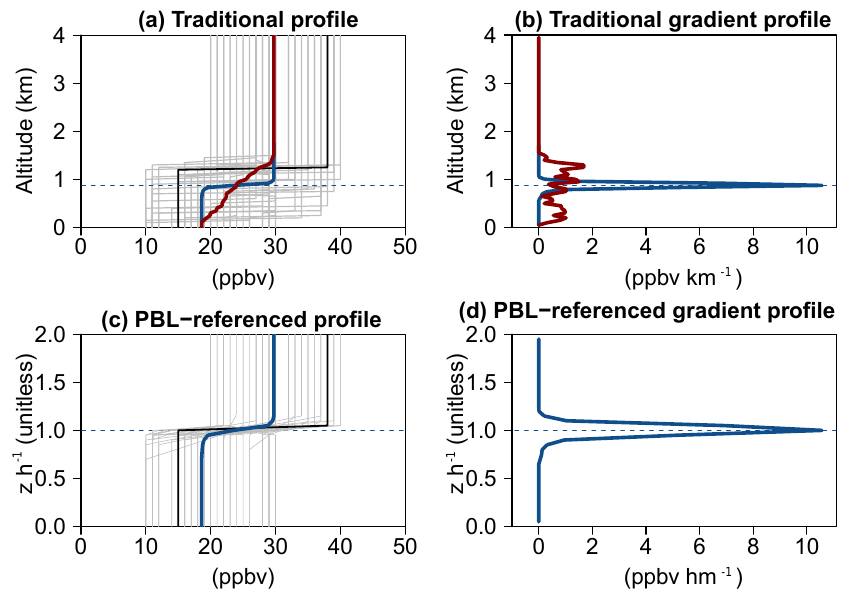
Figure 6. Artificial vertical profiles ( a, c ) and gradient profiles ( b, d ) expressed as a function of z ( a, b ) and z/h ( c, d ). The figure shows all individual profiles (grey lines), one example of an individual profile (black line), the z -referenced mean profile (red line) and the PBL- referenced profile (blue line), and the mean PBL height of this artificial dataset (blue dotted line; see text for